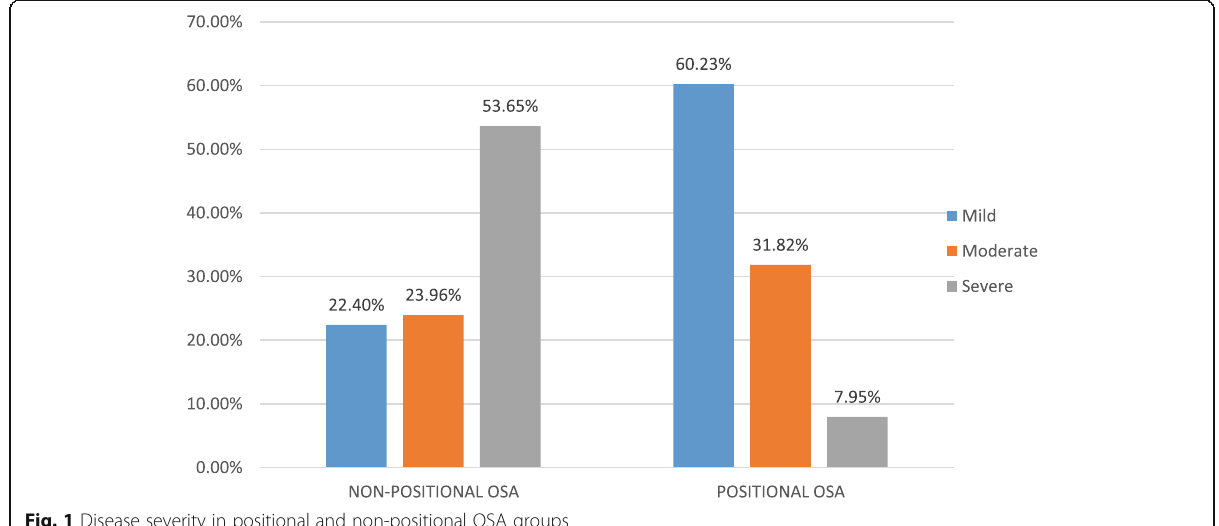
Fig. 1 Disease severity in positional and non-positional OSA